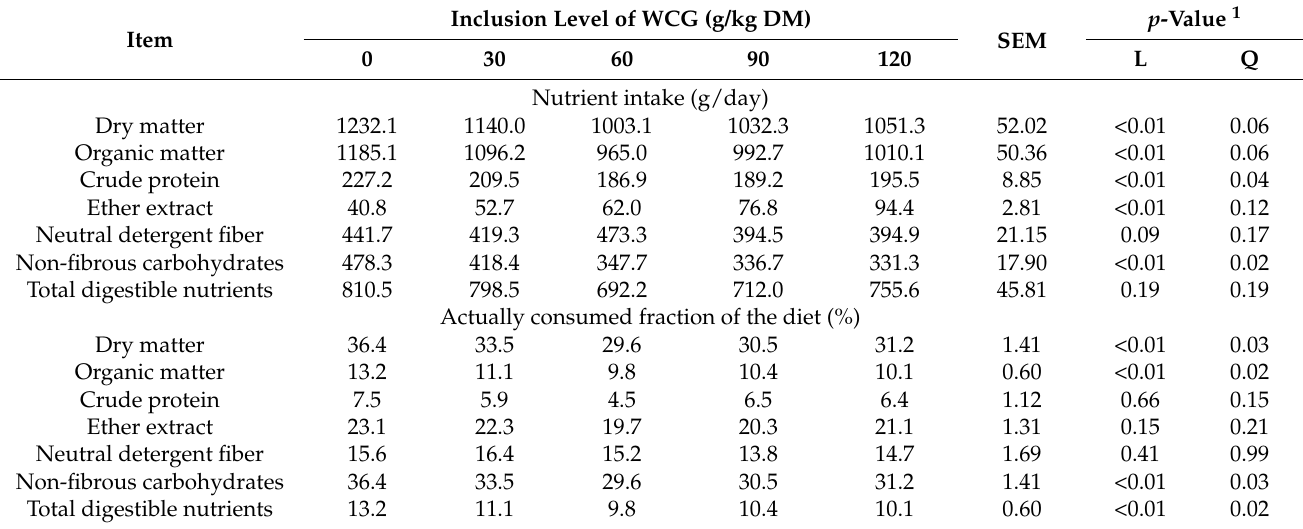
Table 3. Apparent nitrogen balance in lambs fed diets containing whole corn germ.